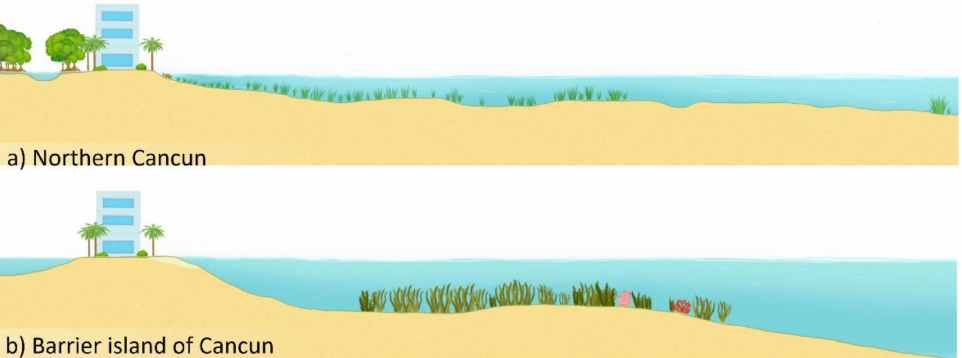
Figure 8. Schematisation of the distribution of coastal environments and characteristic coastal infrastructure at ( a ) northern Cancun and ( b ) the barrier island of